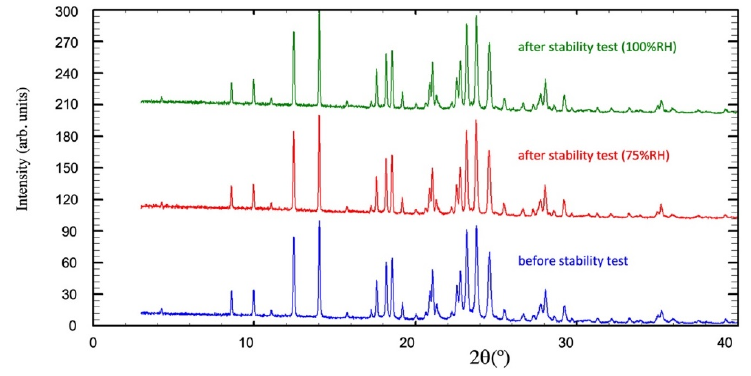
Figure 7. PXRD of piperine–succinic acid cocrystal before and after the stability test.